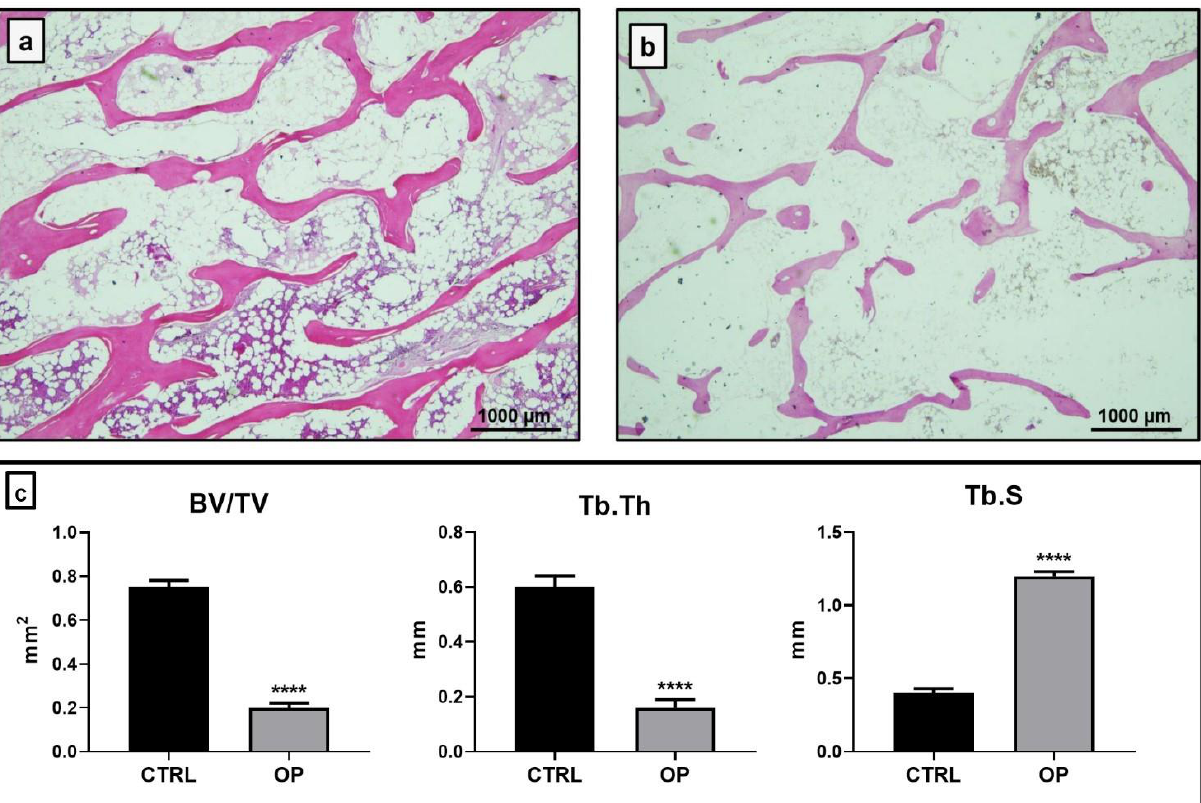
Figure 1. Haematoxylin and eosin (H&E) sections of bone head biopsies and evaluation of bone morphometric parameters. ( a ) Histomorphometrical analysis showed a conserved trabecular network in control (CTRL) patients. ( b ) Osteoporotic (OP) patients displayed a remarkable loss of both trabecular thickness and trabecular number. ( c ) The analysis of bone quality parameters evaluated by NIS-Elements software showed a significant reduction of bone volume (BV/TV) and trabecular thickness (Tb.Th) in the OP group compared to the CTRL group (**** p < 0.0001). In contrast, Tb.S values were significantly reduced in CTRL patients compared to OP patients (**** p < 0.0001). (H&E 2x, scale bar represents 1000 μm).